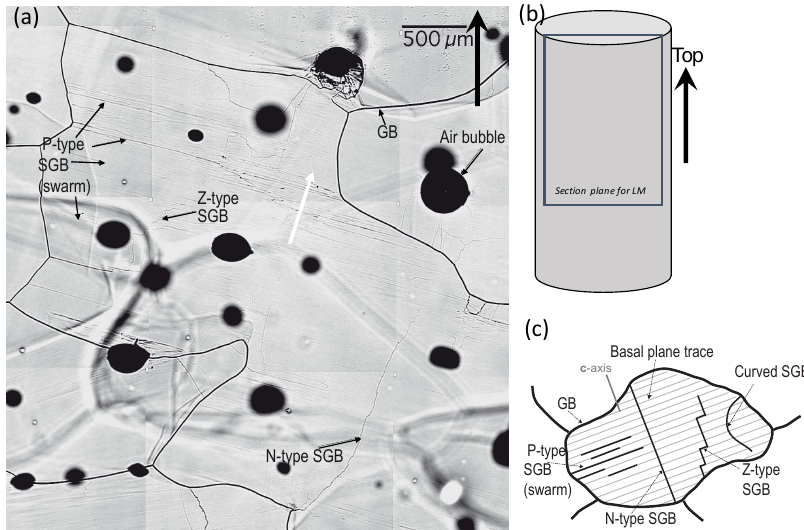
Figure 1. (a) Light microscopy (LM) image of the etched surface of EDML ice (depth 694m). The small black arrow shows different SGS types. The white arrow shows the trace of the c-axis. The large dark features are air bubbles in the ice. Features beneath the surface are out of focus and indistinct. GB is grain boundary and SGB is subgrain boundary. (b) Schematic diagram showing the orientation of sample sections in the ice core. The large black arrows (a, b) point towards the upper surface of the ice sheet. (c) Schematic diagram of the four types of SGBs described in the text (after Weikusat et al.,